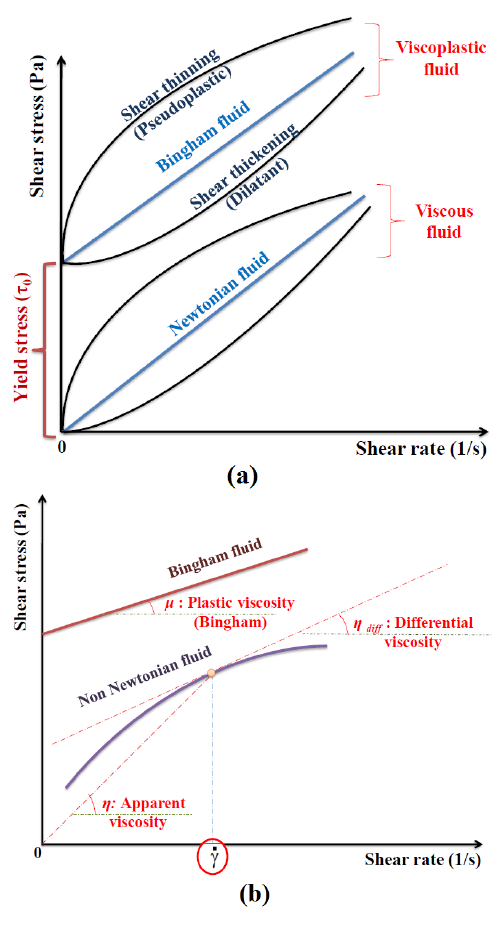
Figure 1: (a) Flow curve for viscous and viscoplastic fluids, (b) graphic representation of differential viscosity and apparent vis- cosity determined at a certain shear